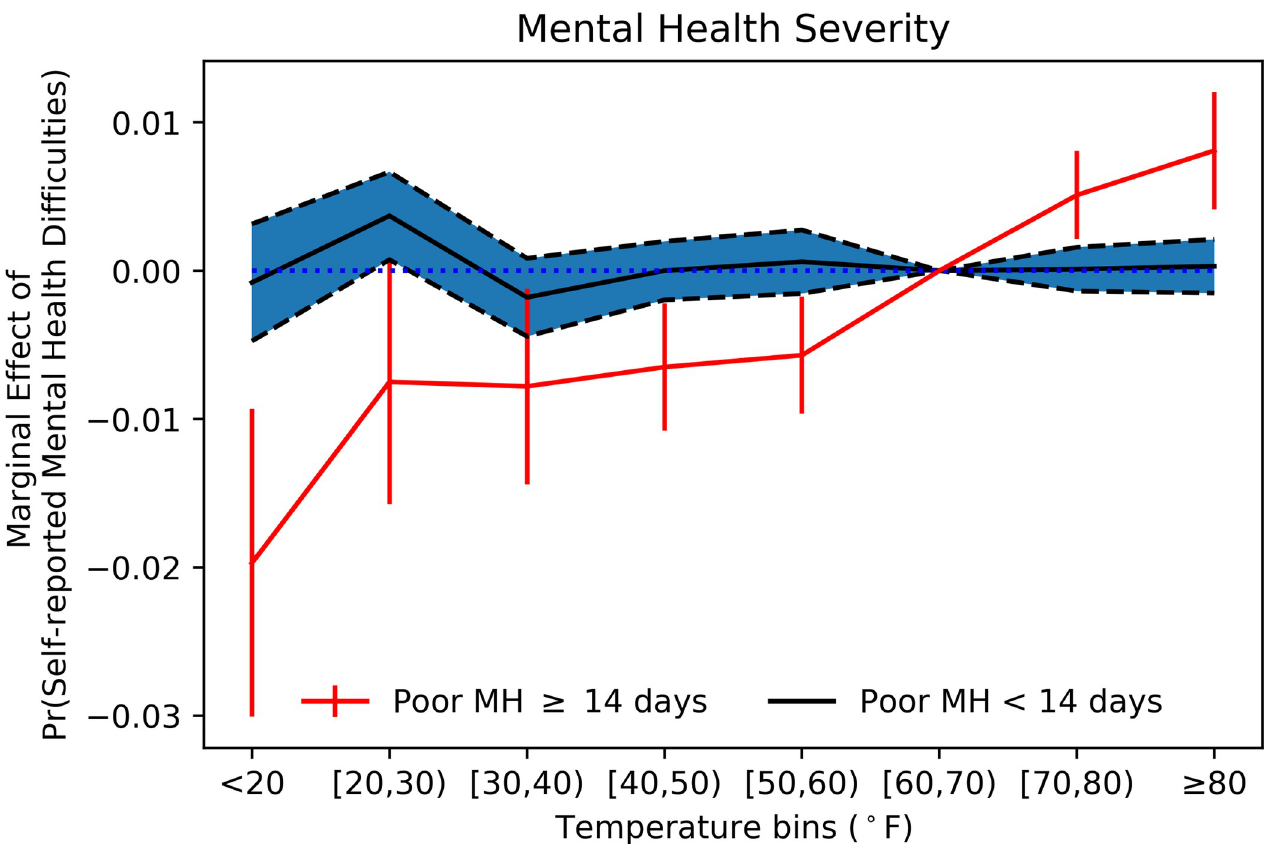
Fig 4. Robustness check by frequent mental distress. The sample is divided based on whether respondents have frequent mental distress (report more than 14 days of bad mental health for the past month). All individual covariates, weather, and location/time controls are included with survey weight applied and 90% confidence intervals